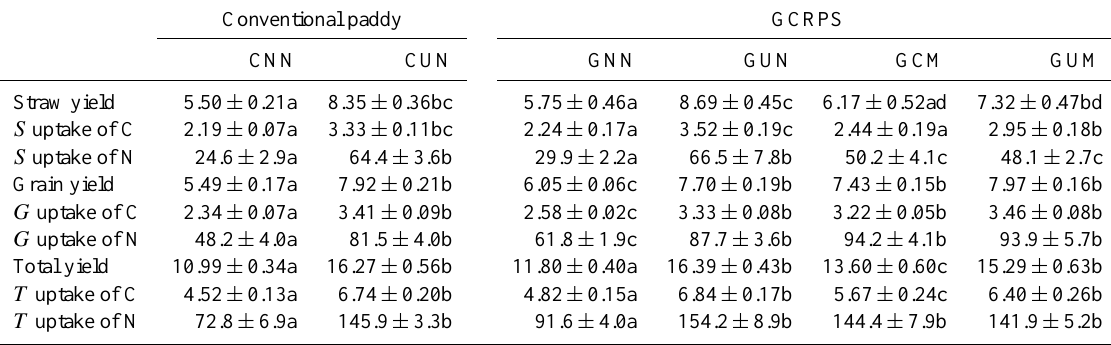
Data shown are means ± standard errors of three spatial replicated plots. Definitions of abbreviations for the different fertilizer treatments are shown in the footnotes of Table 1 and in the text. Different letters within the same row indicate statistically significant differences among treatments at the P <0.05 level.